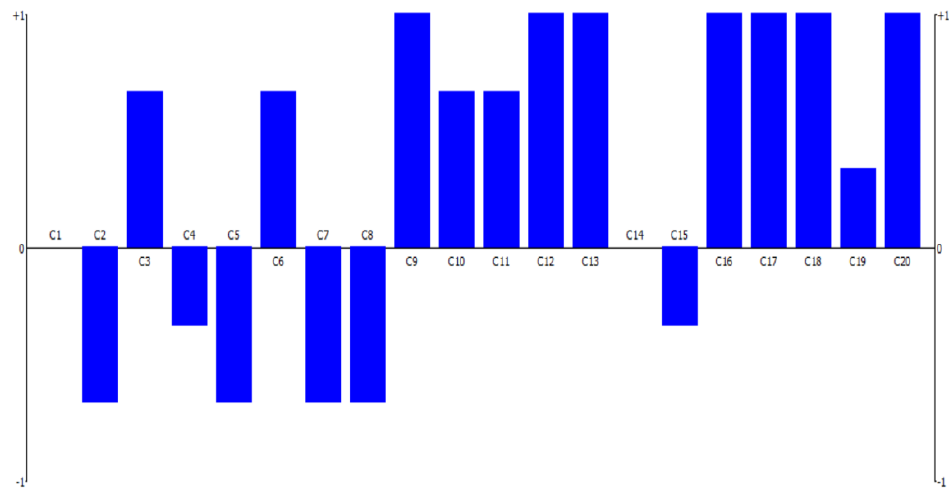
Figure 3. Scoring map of G community for resilience adapted to FFE.